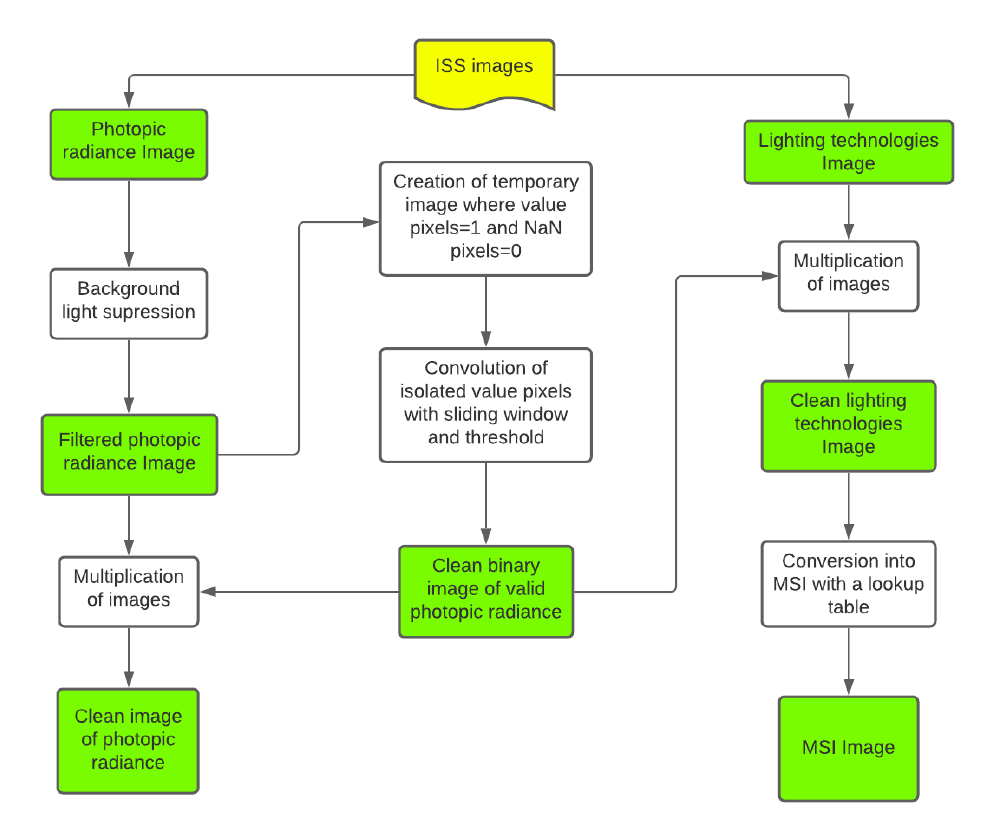
Figure 2. Organizational chart of steps undertaken to remove the background radiance and noise from the ISS